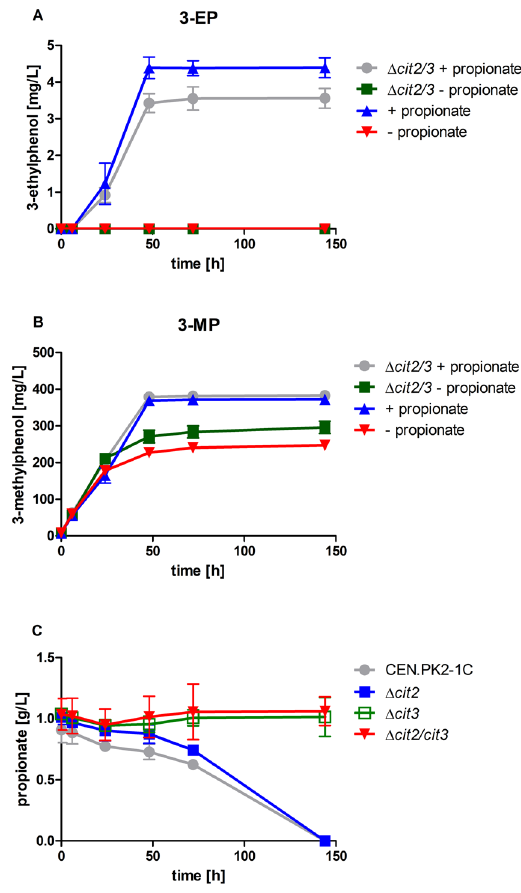
Figure 2. Effect of deletion of methylcitrate synthase genes CIT2 and CIT3 on 3-ethylphenol ( A ) and 3-methylphenol ( B ) formation with or without supplementation of external propionate and on propionate consumption ( C ). CEN.PK2-1C expressing the 3-methylphenol pathway (JHY162) ( Ppopt MSAS , opt npgA and opt patG 14 ) and with the Δ cit2 Δ cit3 double deletion (JHY197) were utilized for high-OD fermentations (starting OD = 5.0) at 30 °C in KP i buffered YPD medium (pH 6.5) with or without supplementation of 10 mM propionate. Propionate consumption was followed in S. cerevisiae wild-type strain CEN.PK2-1C and deletion strains that either had peroxisomal ( Δ cit2 ), mitochondrial ( Δ cit3 ) or both methylcitrate synthases ( Δ cit2/ Δ cit3 ) deleted and were cultured (starting OD = 4) at 30 °C in KP i buffered YPD medium (pH